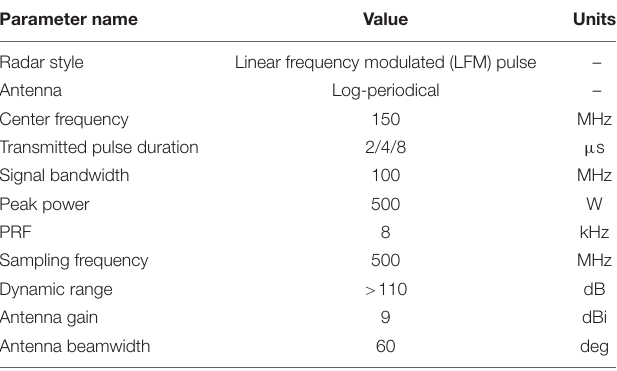
TABLE 1 | The parameters of the ice-penetrating